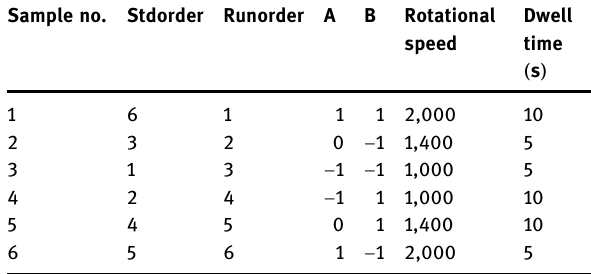
Table 1: Two - level 2 k full factorial design of experiment Sample no. Stdorder Runorder